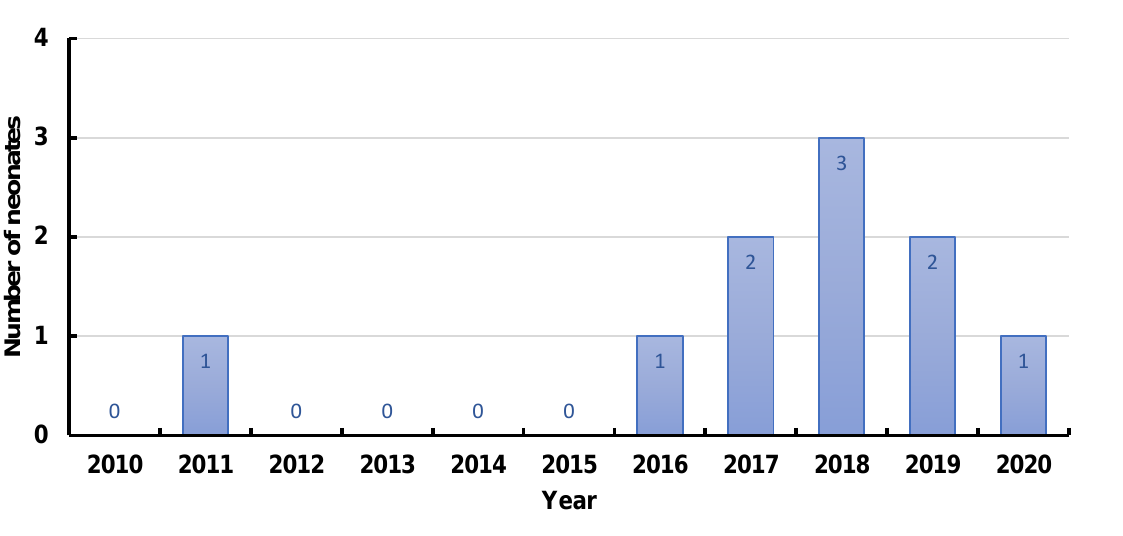
Figure 3. Incidence of neonates with in utero exposure to lithium, born at the University Hospitals Leuven, during the study period.